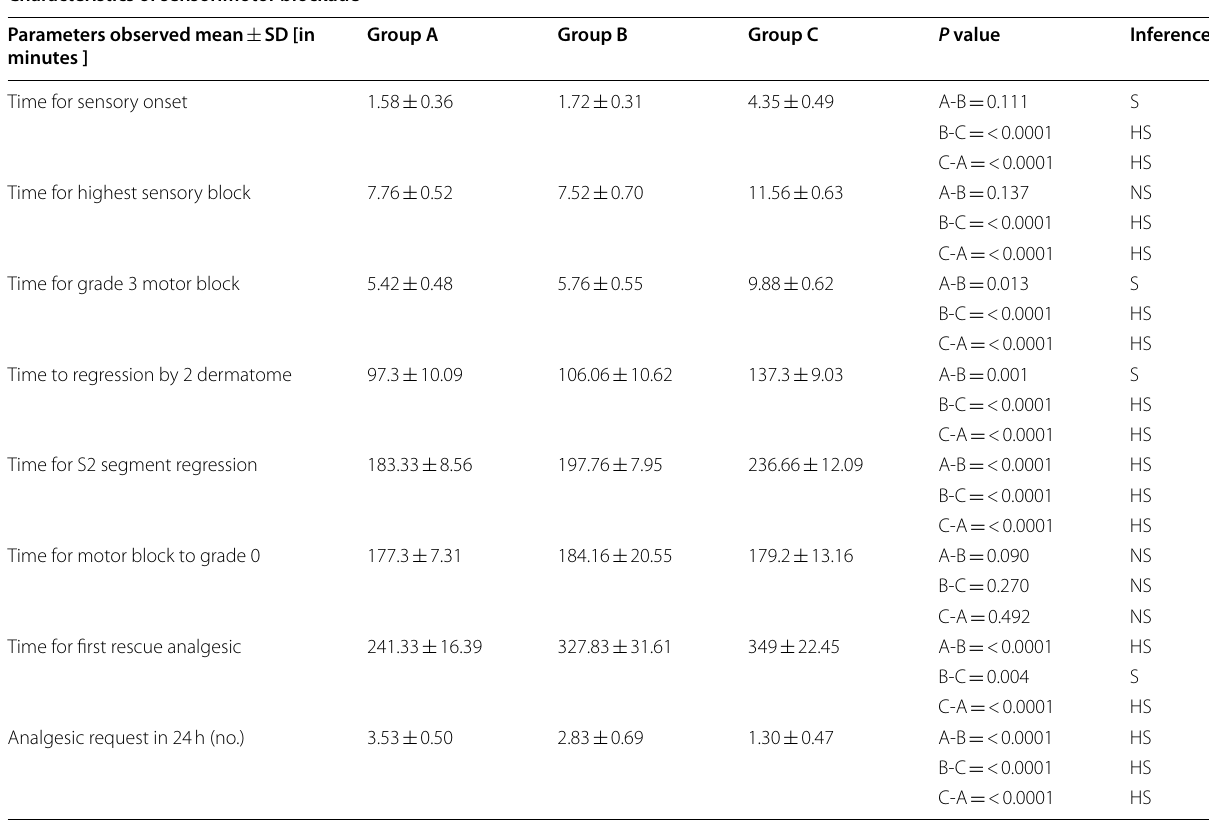
Table 2 Sensorimotor blockade